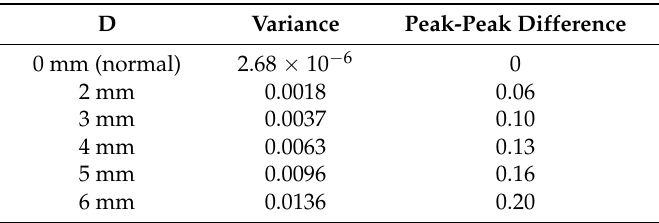
Table 6. Characteristics of TPD under different eccentricities.